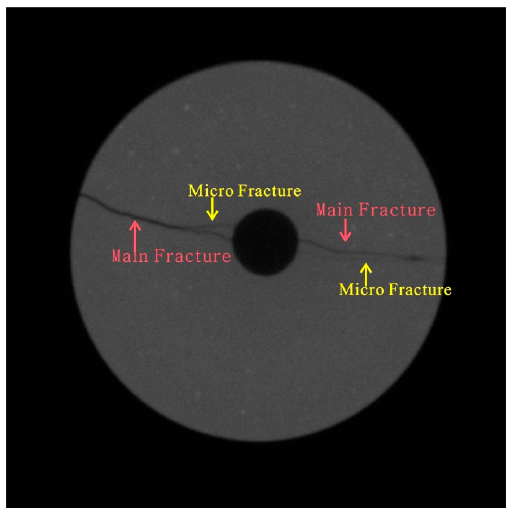
Figure 8. Typical CT image of fractured sandstone core, main fracture and micro fracture.